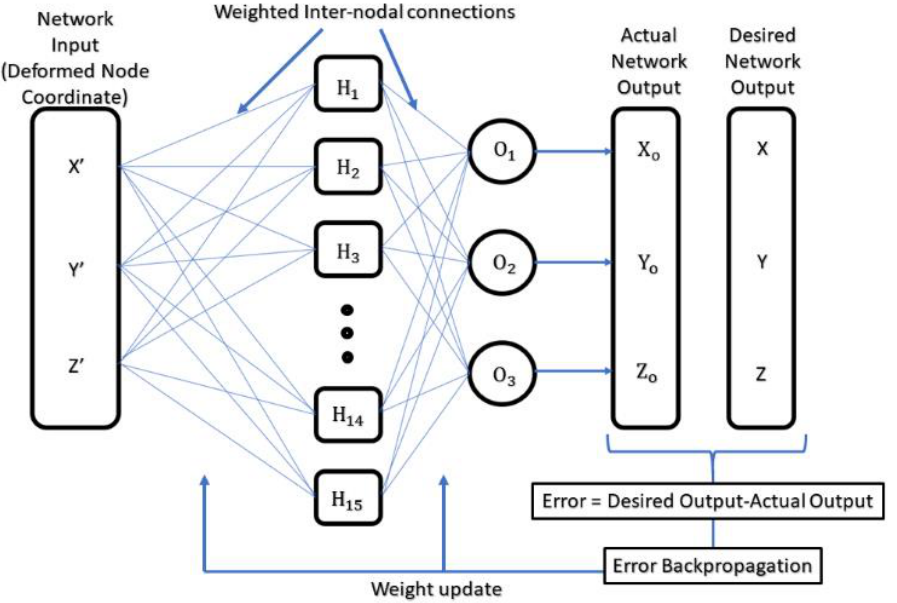
Figure 4. Schematic of ANN-based geometric compensation model.